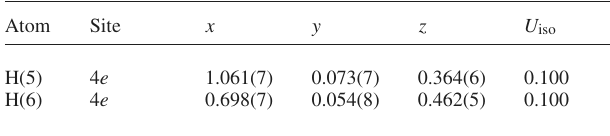
Table 2. Atomic coordinates and displacement parameters (in Å 2 ) . Table 2. Continued